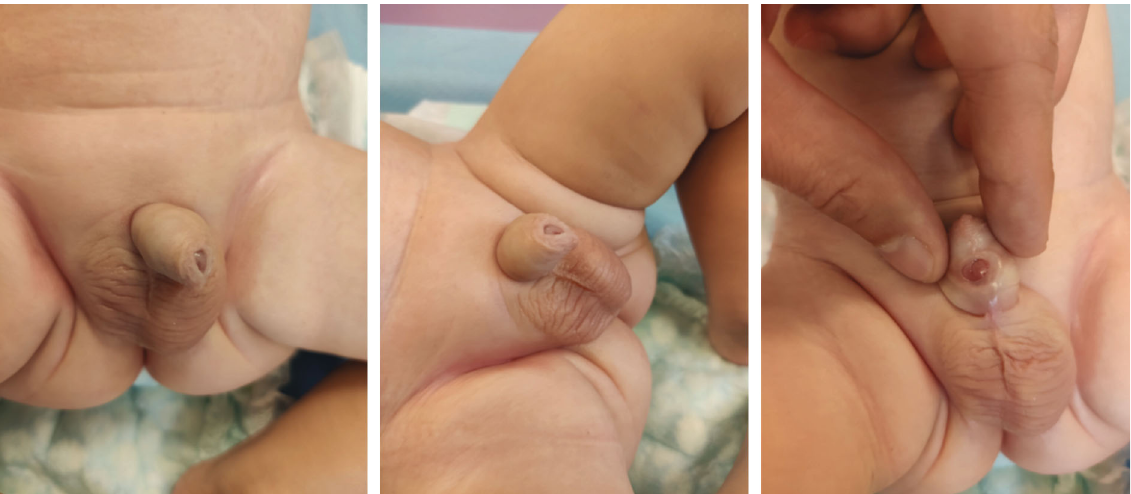
Figure 2: Clinical examination at the age of 3 months: urethrocutaneous fi stula occurs after the rupture of the urethral wall. The patient is urinating from both the normal urinary meatus at the tip of the glans and the ventral urethrocutaneous fi